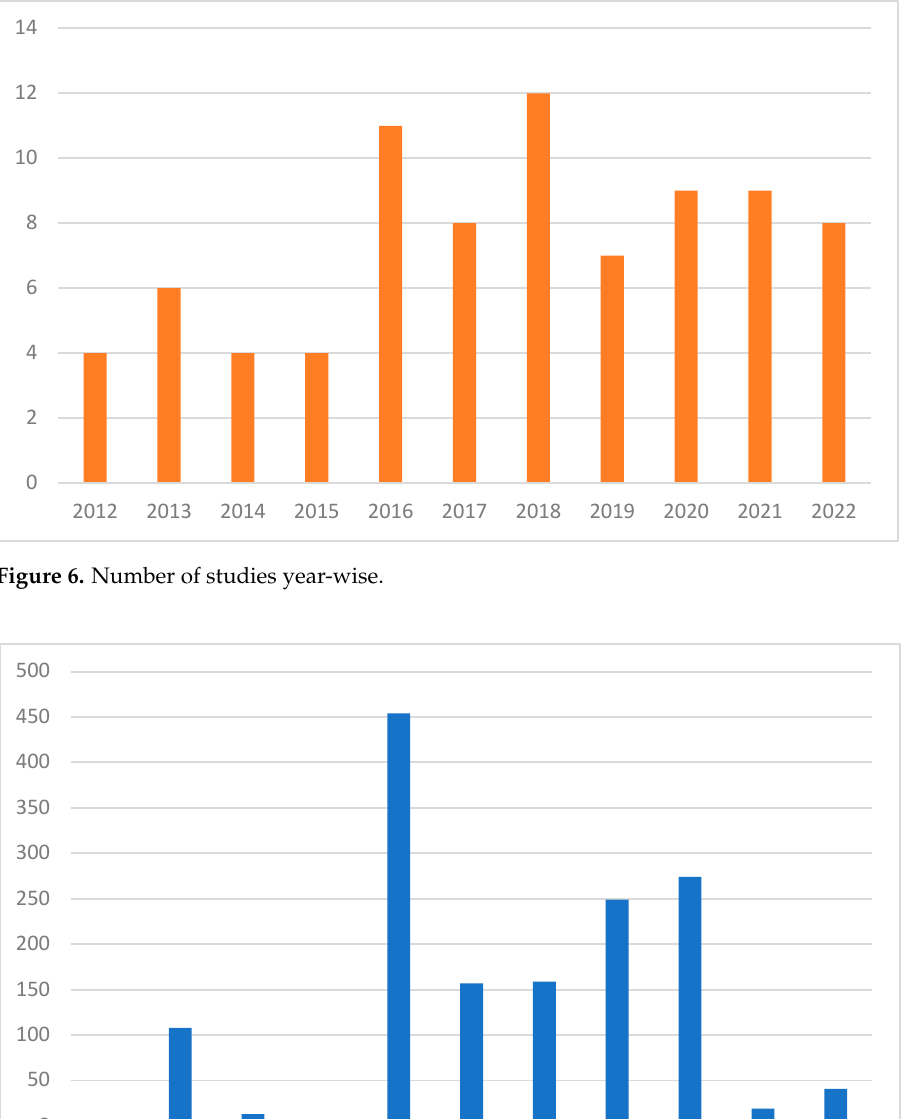
Figure 7. Number of citations year-wise.